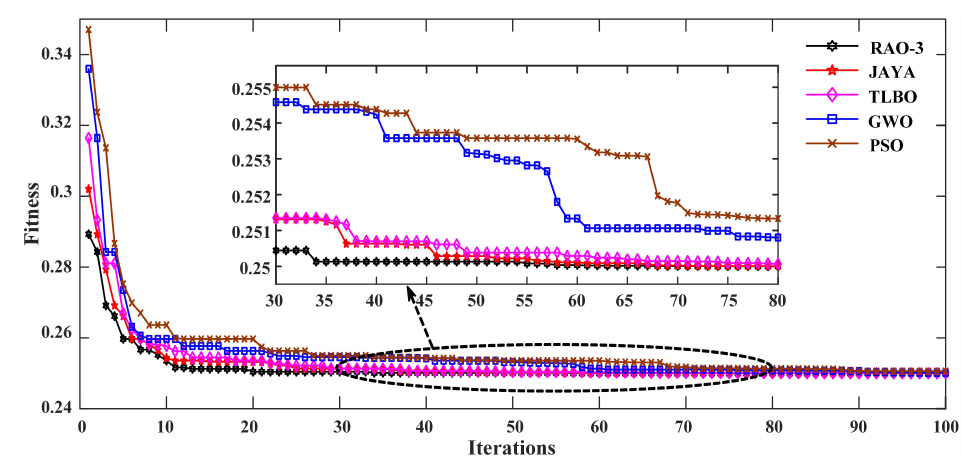
Figure 10. Fitness Curve of DG and